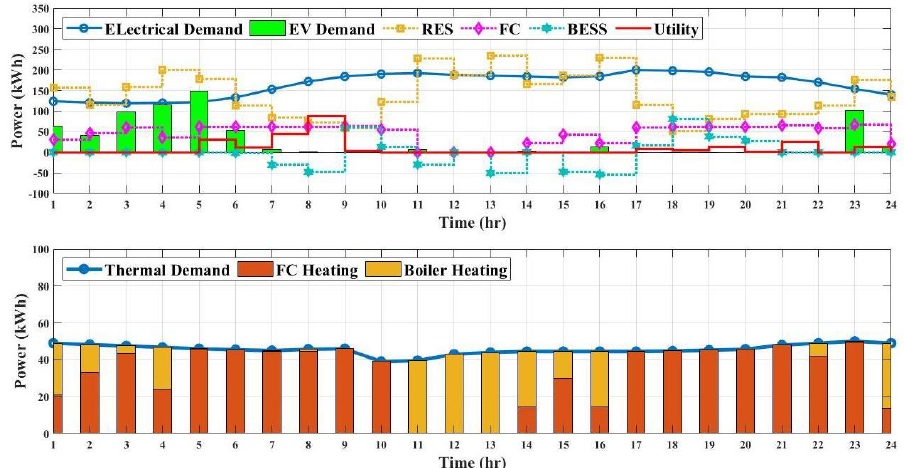
Figure 15. Results of the system with scheduling of EV.